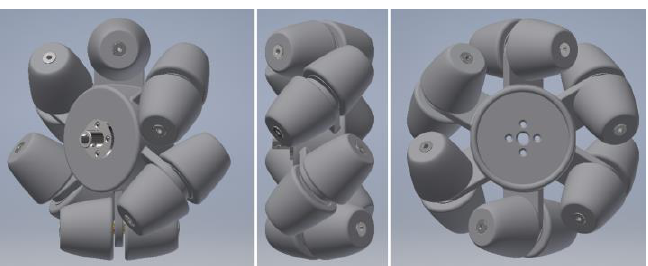
Fig. 3. General view of the mecanum wheel under consideration.